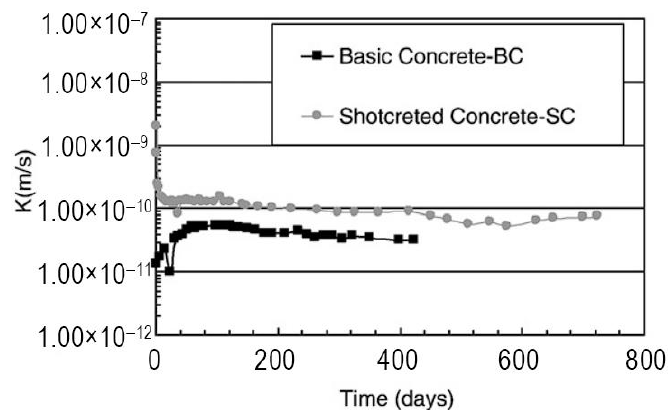
Figure 19. Variation of hydraulic permeability of concrete over time of the experiment [65].